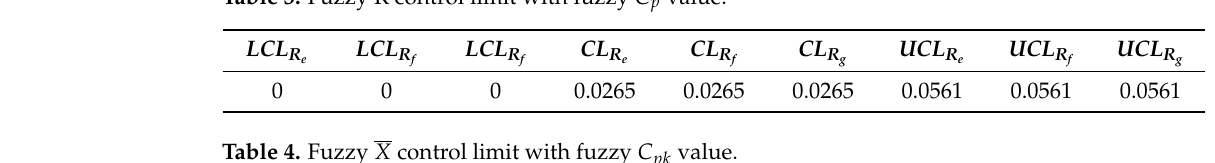
Table 3. Fuzzy R control limit with fuzzy C p value.